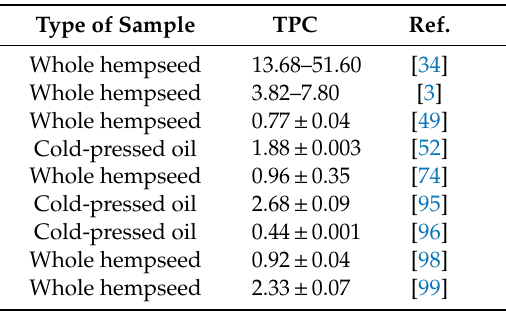
Table 9. Total phenolic content (mg Gallic Acid Equivalent (GAE) / g) of hempseed cold-pressed oil or whole